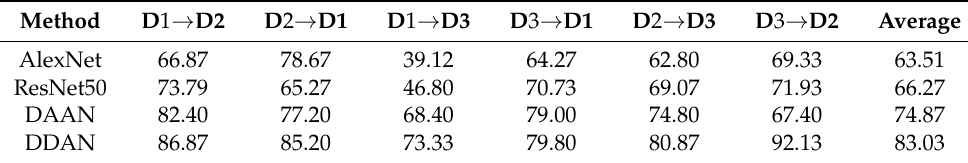
Table 3. Classification accuracy (%) on the TCM dataset with six transfer tasks.